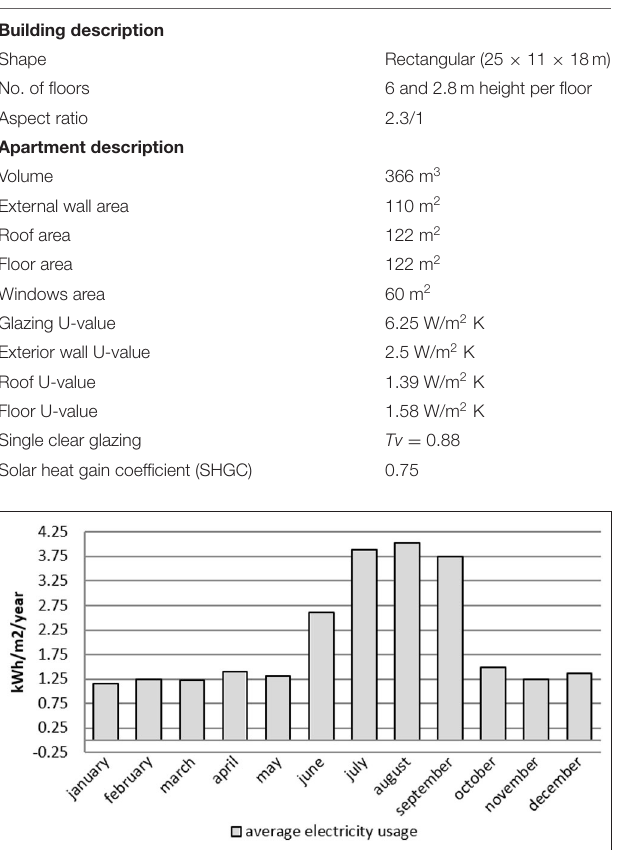
TABLE 3 | Building description.